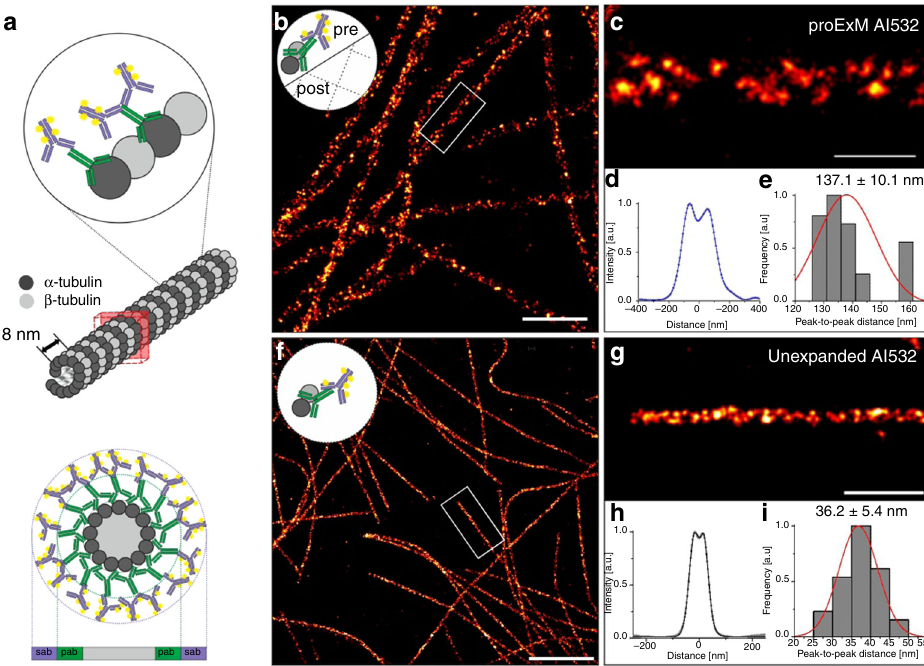
Fig. 1 Re-embedding enables Ex- d STORM. a Model of microtubules with an outer diameter of 25 nm stained with conventional primary (pab) and fl uorescently labeled secondary IgG antibodies (sab) results in a total diameter of 60 nm with a linkage error (de fi ned by the size of the primary and secondary antibody) of 17.5 nm 22 . b d STORM image of pre-labeled proExM expanded and re-embedded Cos-7 cells stained with primary antibodies against α -tubulin and secondary Alexa Fluor 532 conjugated antibodies (Al532). The small logo in the upper left corner symbolizes that microtubules have been immunolabeled before expansion (pre-labeled). c Zoom in on highlighted region in ( b ). d Averaged cross-sectional pro fi le of nine microtubule segments with a total length of 29.1 µ m (segment lengths range from 2.1-4.5 µ m) measured in two cells from 1 expanded sample. e Histogram of peak-to- peak distances with normalized normal distribution curve (red) determined by bi-Gaussian fi tting of the data analyzed in ( c ) with an average distance of 137.1 ± 10.1 nm (mean ± sd). The data were obtained from n = 9 microtubule segments in 2 cells from 1 expanded sample. f Unexpanded Cos-7 cells labeled with an anti α -tubulin primary antibody and Alexa Fluor 532 (Al532) conjugated IgG secondary antibodies. The small logo in the upper left corner symbolizes that microtubules have been immunolabeled and not expanded. g Zoom in of the white boxed region in ( f ). h Average intensity pro fi le of 35 microtubule segments with a length between 1.1 and 5.8 µ m (mean = 2.0 µ m) and a total length of 69.6 µ m analyzed in 12 d STORM images. i Histogram of peak-to-peak distances with normalized normal distribution curve (red) determined by bi-Gaussian fi tting of cross-sectional pro fi les of the analyzed microtubule segments in ( h ) with a mean peak-to-peak distance of 36.2 ± 5.4 nm (mean ± sd). The data were obtained from n = 35 microtubule segments in 12 cells and 3 independent experiments. Scale bars, 2 µ m ( b , f ), 500 nm ( c , g